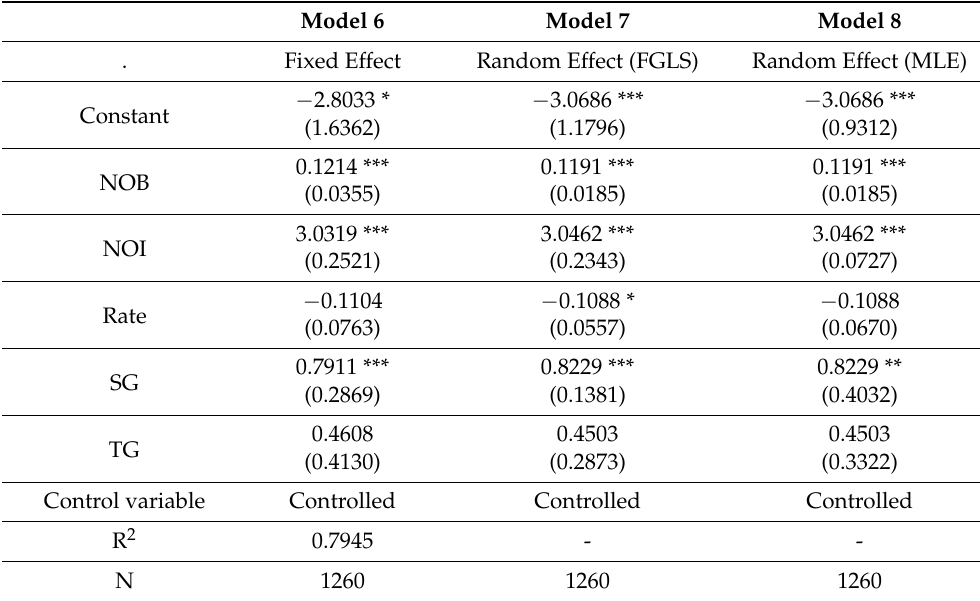
Table A1. Regression results of fixed effect model and random effect model.